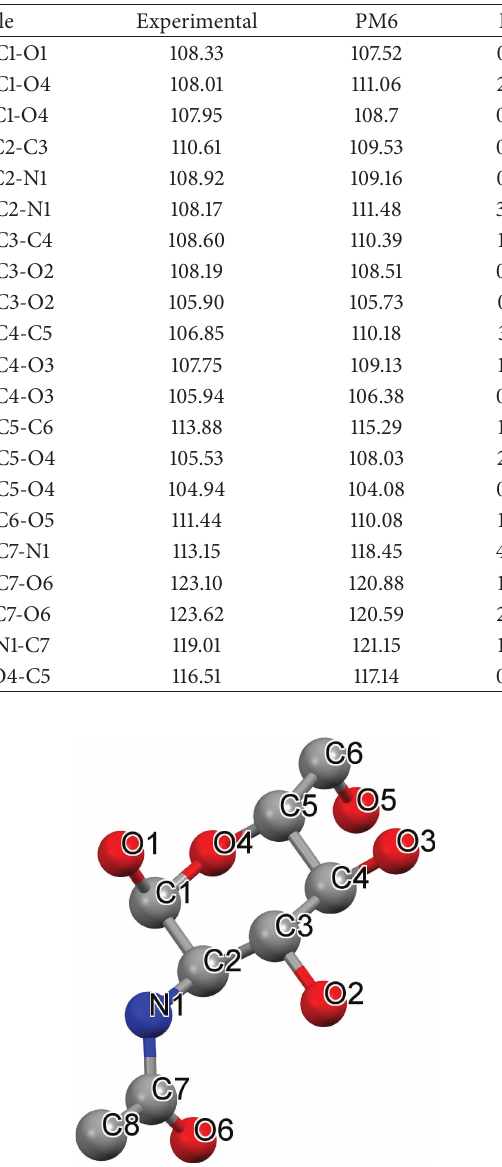
Figure 6: Atom labels used in the comparison of the molecular